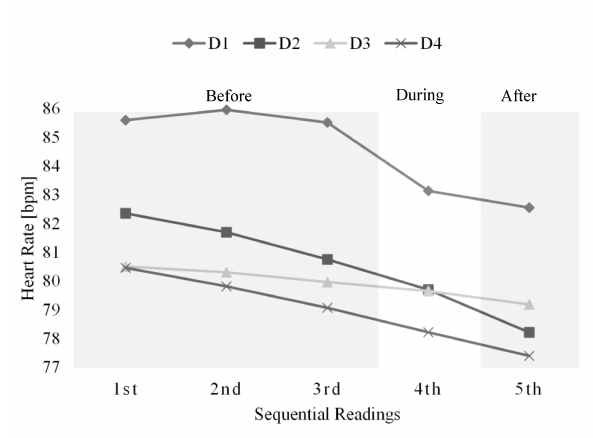
Fig. 4. Average heart rate for all golfers at different distances from the hole. The heart rate value is obtained on different occa- sions whenever a putt occurs as previously presented in Fig.